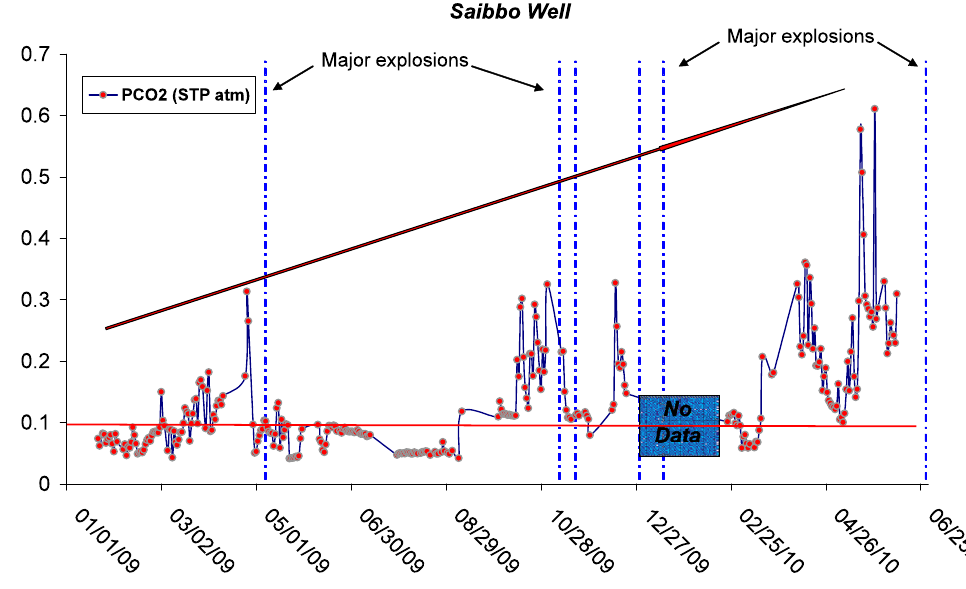
Figure 10. Long-term variations of P (STP, atm) for Saibbo well, as acquired from continuous recordings. Vertical blue dashed lines, major explosions CO2 from the summit craters of Stromboli volcano from January 2009 to June 2010.